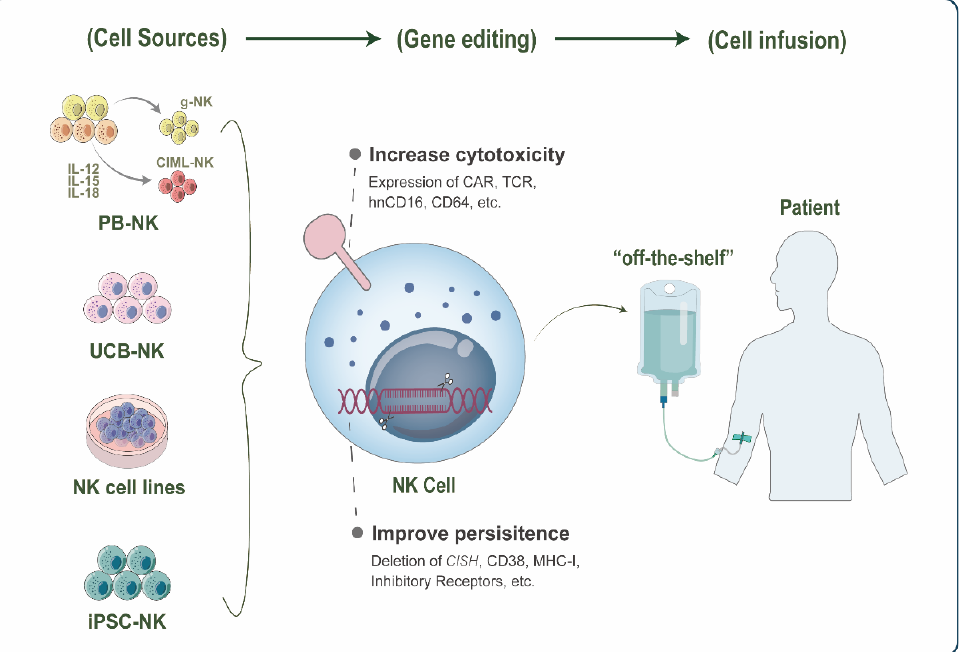
Figure 2. Schematic representation of Natural killer (NK)-based adoptive cell therapy (ACT). NK cells for adoptive infusion come from a wide range of sources, including peripheral blood NK (PB-NK) cells, umbilical cord blood NK (UCB-NK) cells, NK cell lines, and induced pluripotent stem cell (iPSC)-derived NK cells. In PB, the novel FcRg-deficient NK(g-NK) subset and cytokine-induced memory-like NK (CIML-NK) have become promising cell sources in ACT with their enhanced antitu- mor activity and memory properties. Various gene editing strategies further enhance the function of therapeutic NK cells, with two main focuses: increasing NK cell cytotoxicity and improving persistence in vivo. Finally, these engineered NK cells can be infused into patients as “off-the-shelf” products for cancer